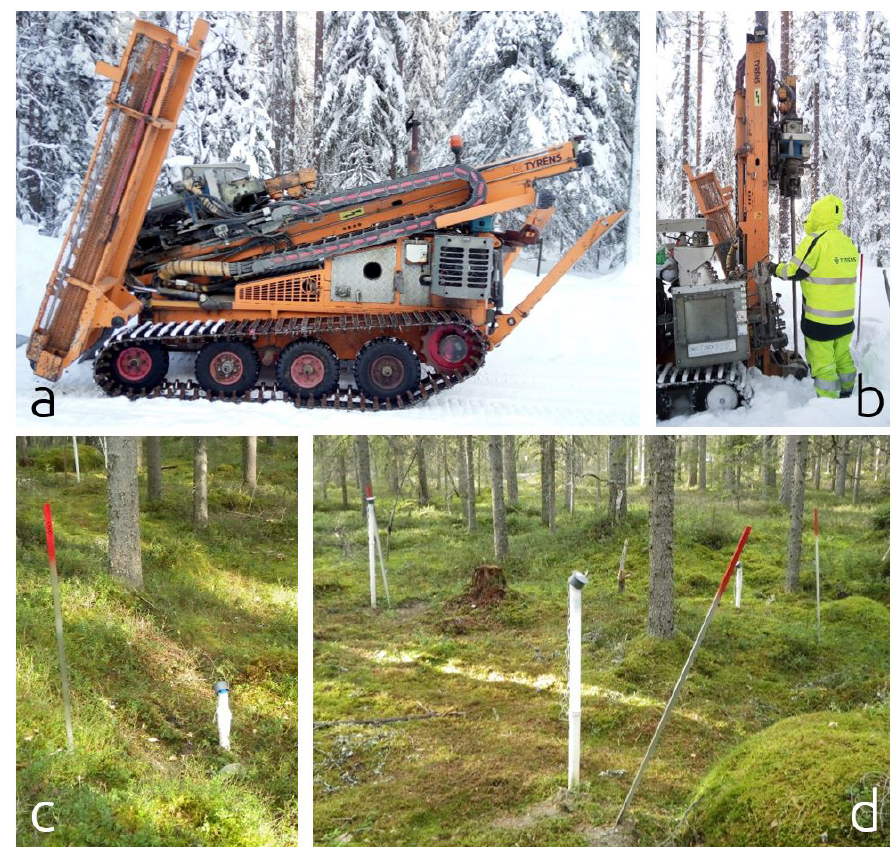
Figure 3. (a, b) Well installation in winter 2019. (c, d) Pictures of closely positioned wells that form triangles (length of the pipe above the ground is ∼ 50cm in panel c and 110cm in panel d ). The gray caps were placed over the loggers for protection. The aluminum poles with the red paint next to the wells were used to determine the location of the wells when snow covered the ground.